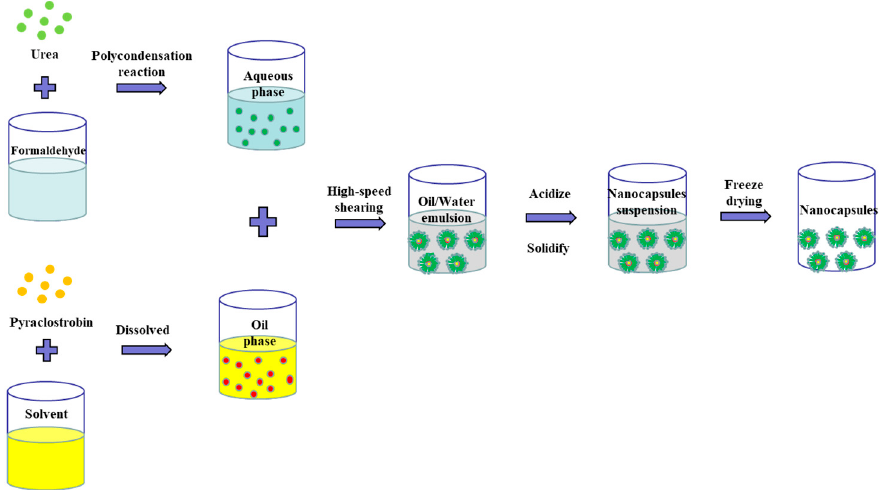
Figure 1. Schematic illustration of pyraclostrobin